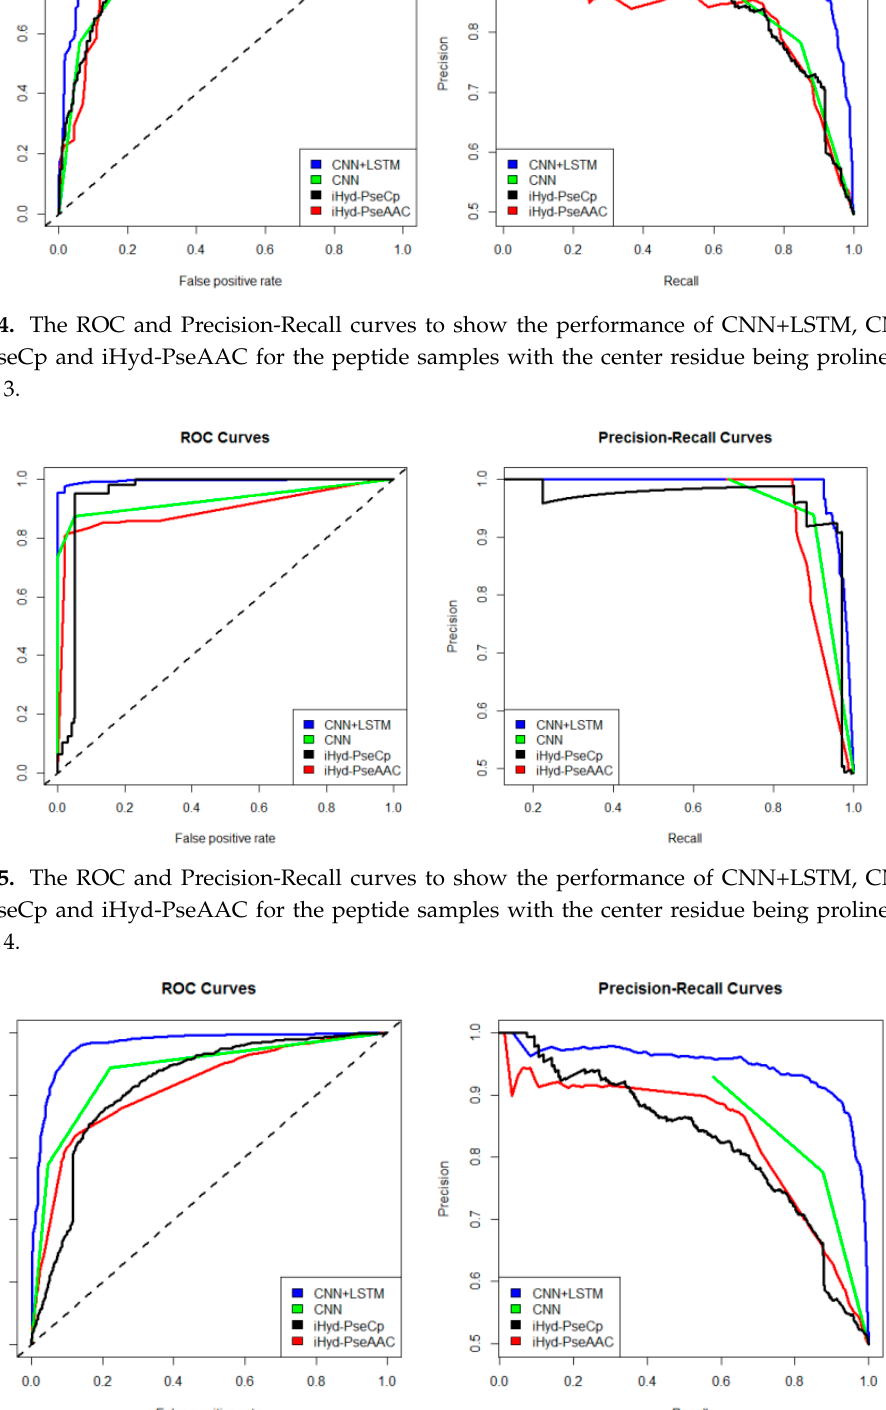
Figure 6. The ROC and Precision-Recall curves to show the performance of CNN+LSTM, CNN, iHyd-PseCp and iHyd-PseAAC for the peptide samples with the center residue being proline on Dataset 5.